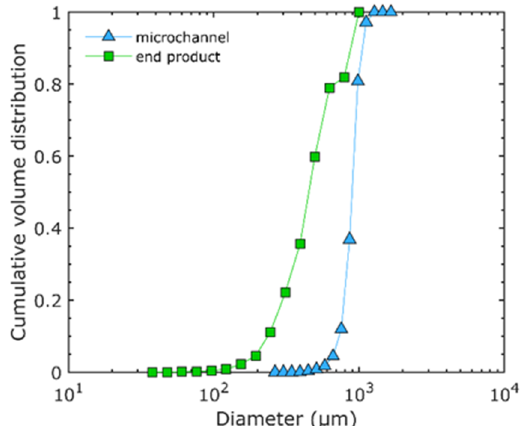
Figure 7. Cumulative volume distribution of bubbles using the model solution WPI3XG04 and the microsystem CX600 at Q vL = 11 L.h −1 , Q mG = 21.6 g.h −1 , P inj = 3.83 bar. Size distribution of bubbles inside the microfluidic device (triangles) and in the end product (squares). The diameters of bubbles inside the microchannels are normalized to the atmospheric pressure (outlet pressure). Adapted from [22] with permission from